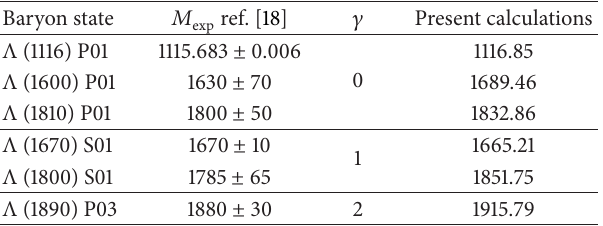
Table 4: The present calculations of Λ baryon states in comparison to the experimental data [18] in (MeV).